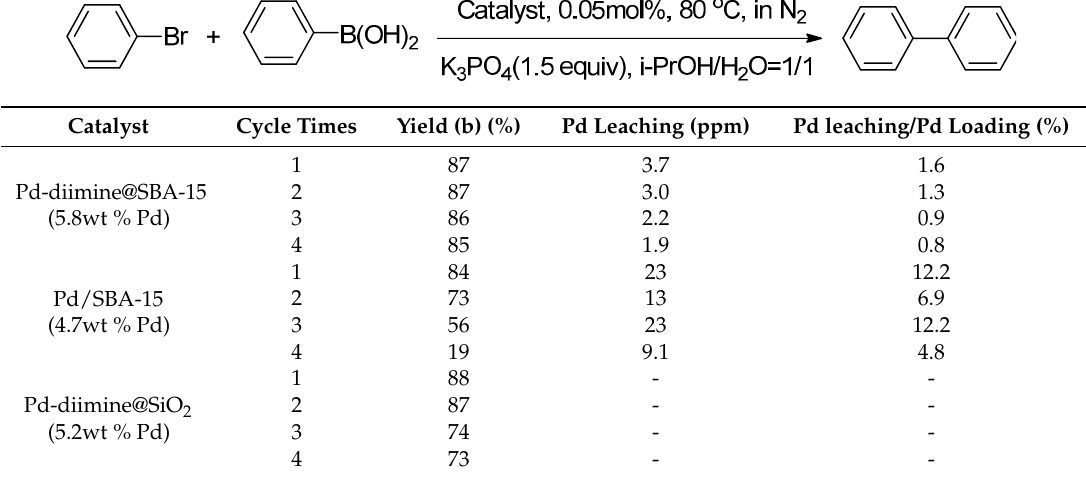
Yield (b) (%) Catalyst Cycle Times Yield (b) (%) Pd Leaching (ppm)